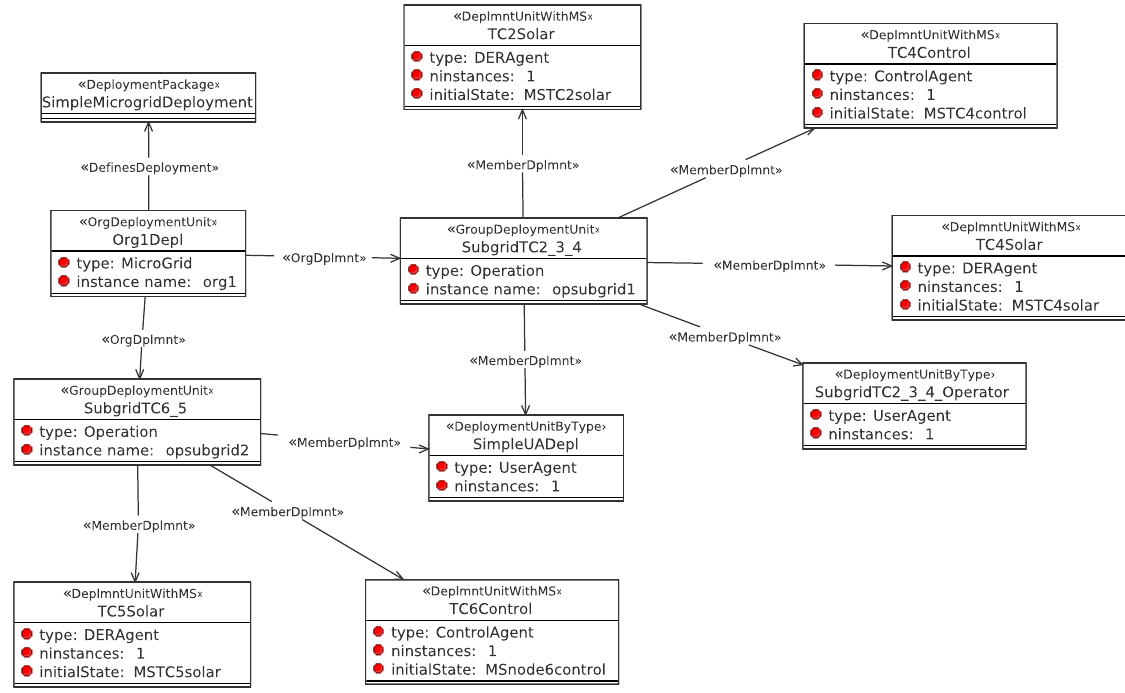
Figure 9. New I2DAPS deployment for the Microgrid from Figure 8.